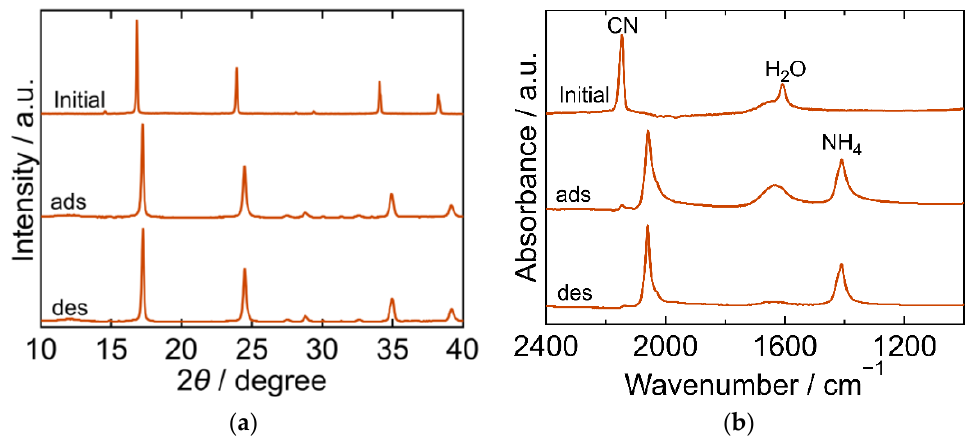
Figure 7. XRD patterns ( a ) and FTIR spectra ( b ) of manganese hexacyanoferrate (MnHCF). “Initial” sample is literally the sample before adsorption. The samples after adsorption and desorption are denoted by “ads” and “des”, respectively. The measurements were performed at ambient tempera- ture.